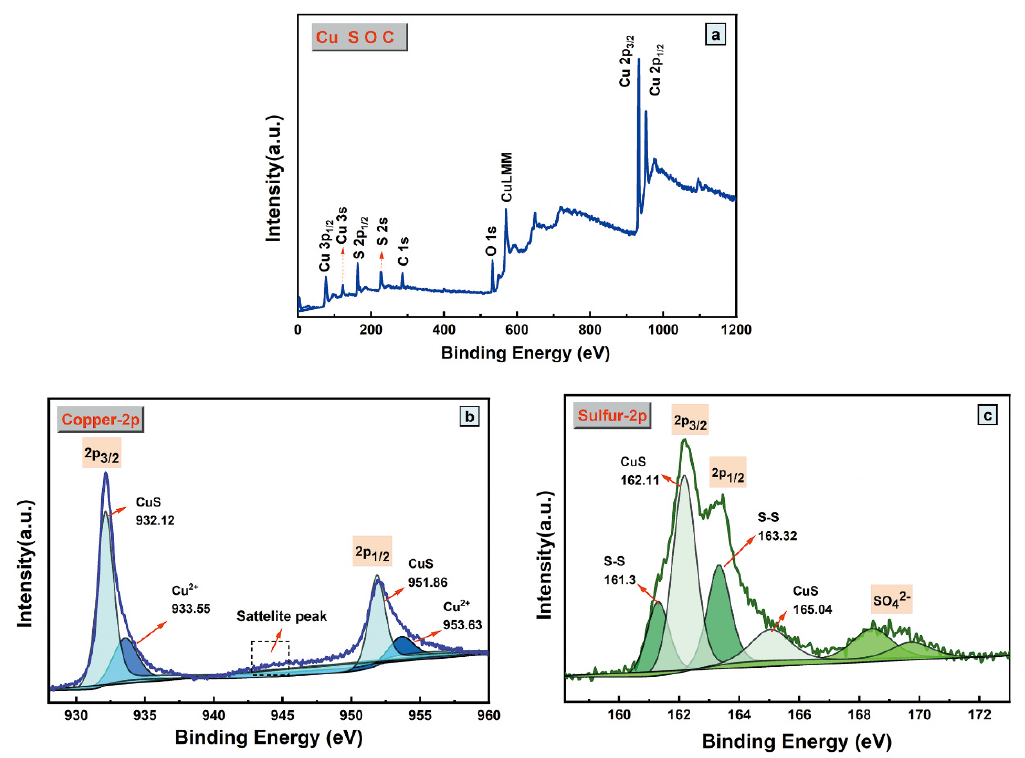
Figure 6. ( a ) Full XPS patterns of CuS/C ‐ 120; XPS patterns of ( b ) Cu 2p and ( c ) S 2p.